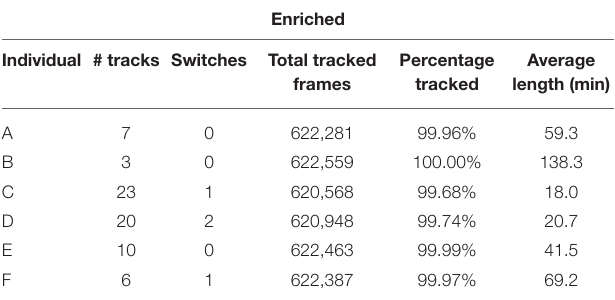
TABLE 1 | Summary of tracking results in barren and enriched environment.